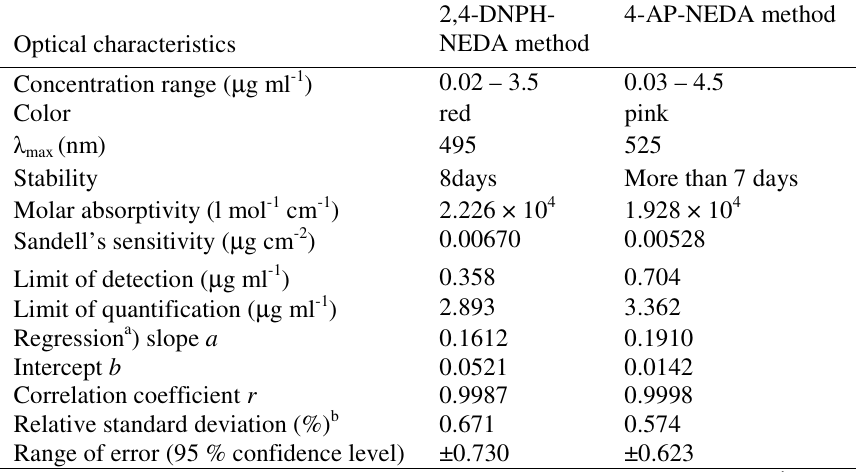
Table 1 . Optical characteristics, precision and accuracy of the spectrophotometric determination of vanadium with 2,4- DNPH-NEDA and 4-Amino Pyridine -